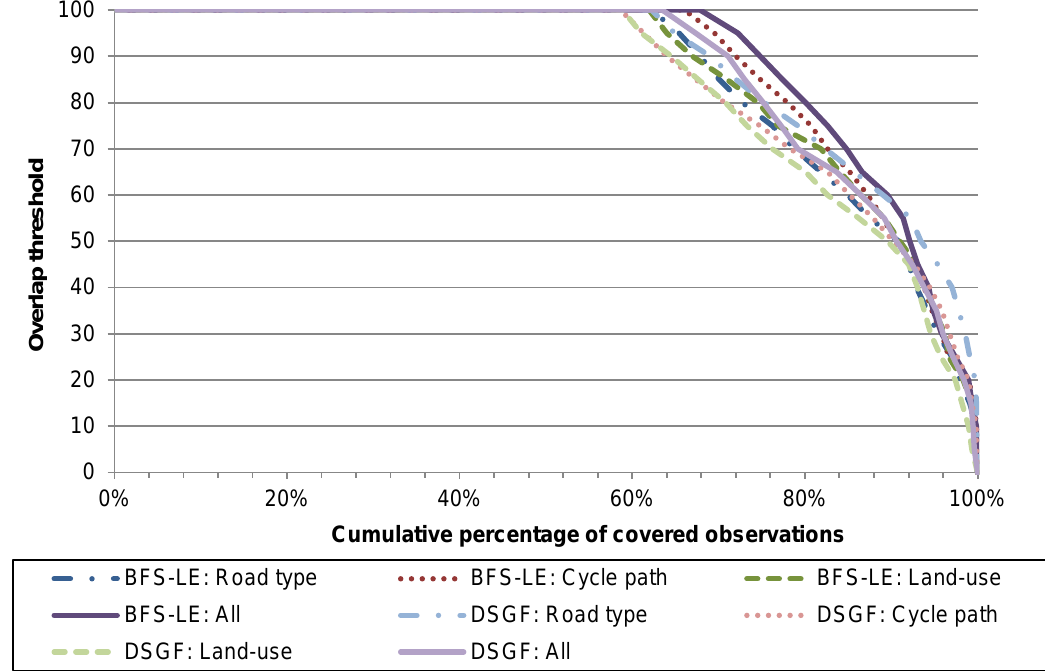
Figure 2. Distribution of coverage over 778